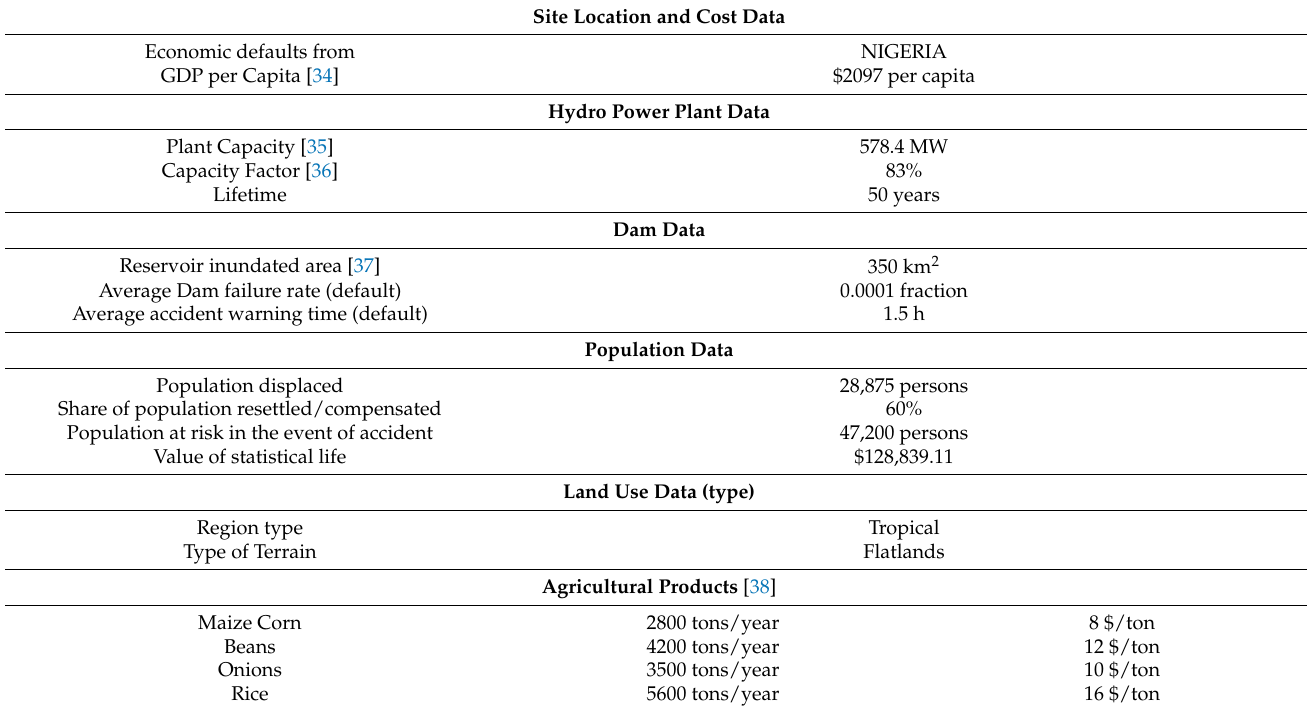
Table 4. Input data for Jebba hydropower plant simulated in SIMPACT